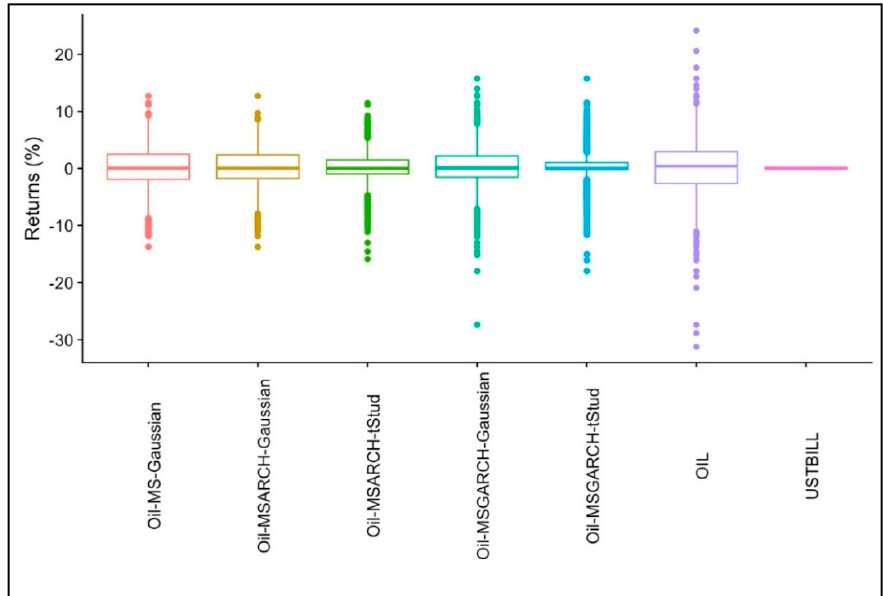
Figure 2. Box plot of the returns of five simulated scenarios in the WTI oil continuous. Source: Own elaboration with results of our simulations and data from Refinitiv Eikon [72].